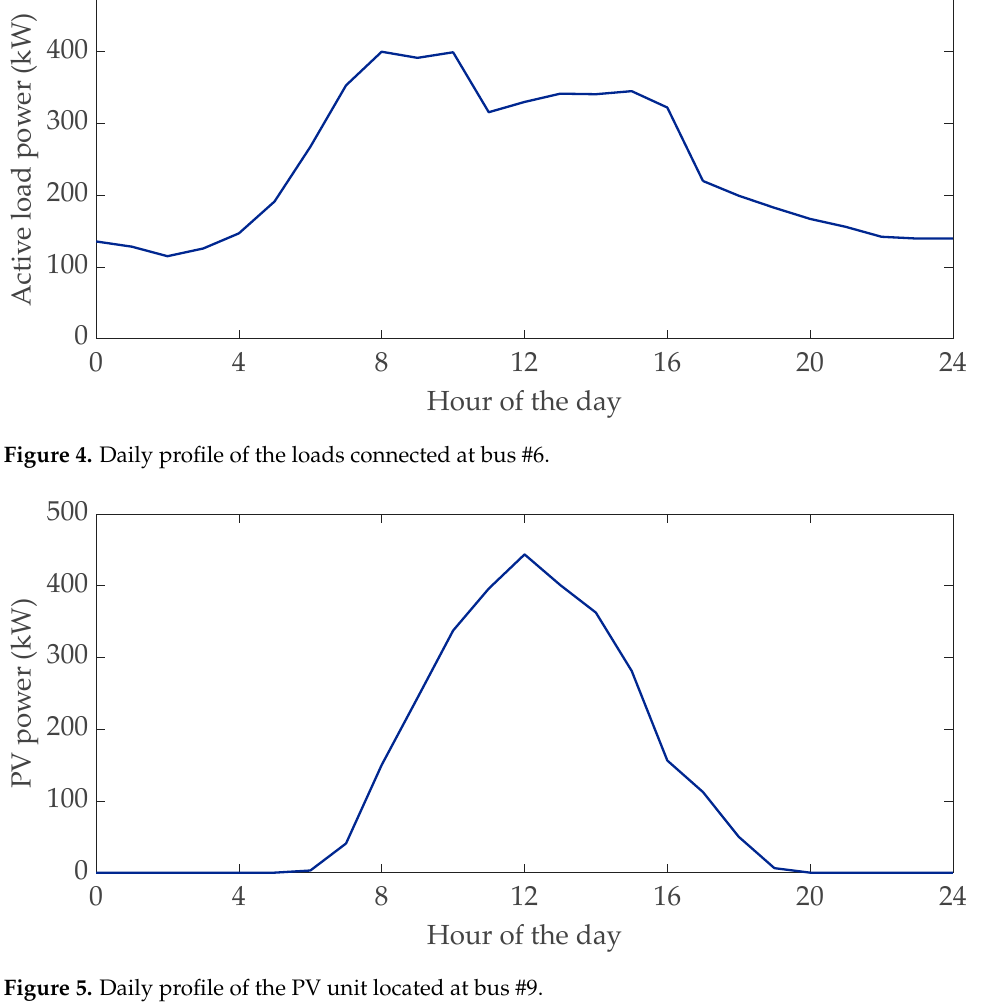
Figure 5. Daily profile of the PV unit located at bus #9.